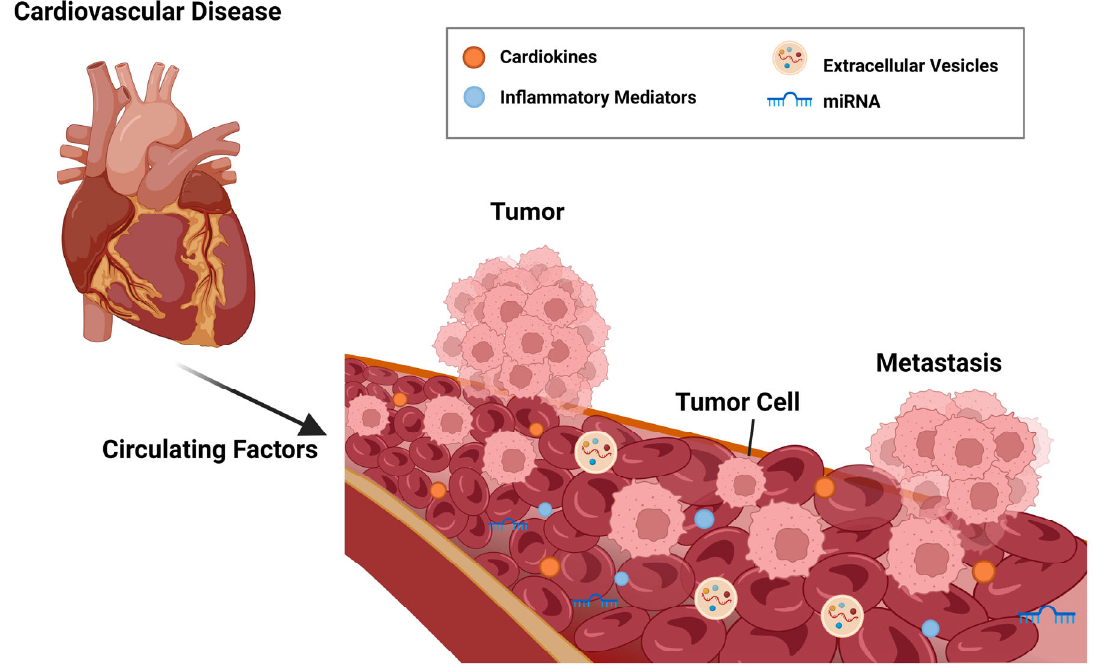
Figure 6. Mechanisms of reverse cardiac oncology (schematic). Secreted factors from the damaged heart promote the growth and metastasis of tumor cells through the circulation. Created with